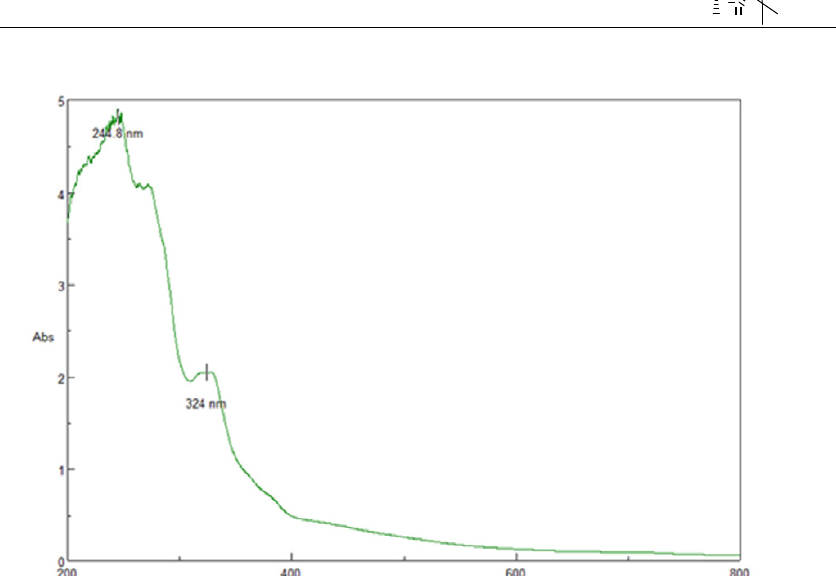
Fig. 1. UV-Vis spectrum of biosynthesized Sm 2 O 3 after 24h with the ratio of Sm(NO 3 ) 3 : Rose of Sharon